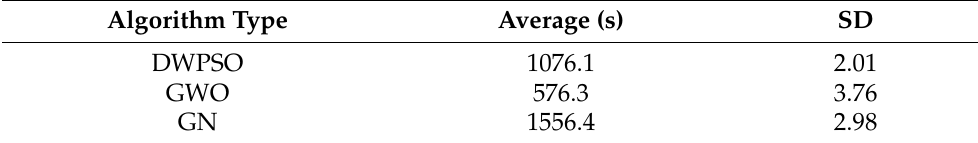
Table 1. Average and standard deviation (SD) of 15 computation times of the DWPSO, GWO, and GN. Algorithm